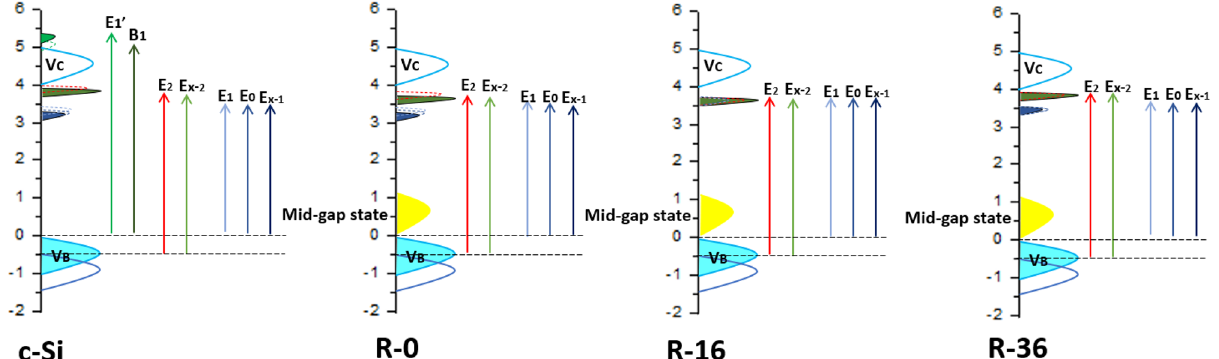
Figure 5. Schematic diagram of electronic band-structure in c-Si, R-0, R-16, and R-36.